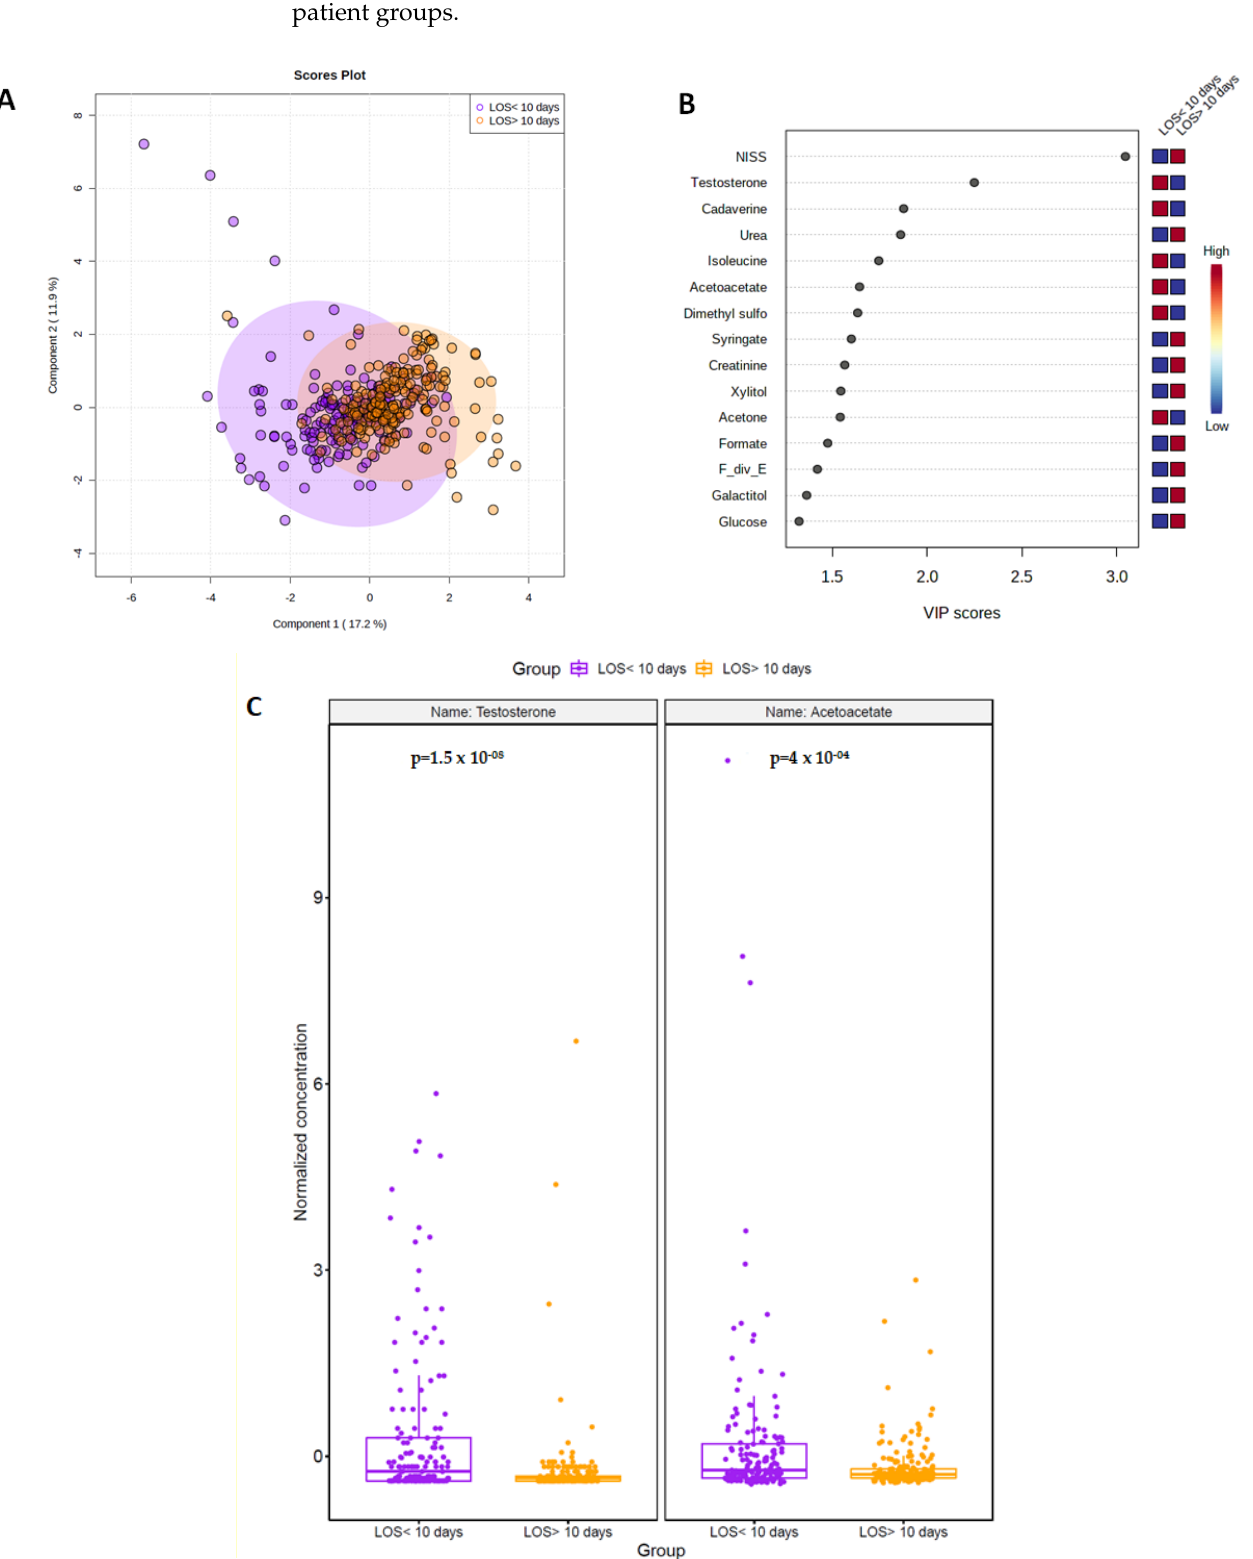
Figure 2. Trauma patients with an ICU LOS ≥ 10 days present with a distinct serum metabolome in the acute post ‐ injury phase. ( A ) A PLS ‐ DA score plot highlighting the differences in the serum metabolome in the acute post ‐ injury phase of patients with an ICU LOS < 10 (purple dots) or LOS ≥ 10 days (orange dots). ( B ) VIP score plot showing the 11 selected features with a VIP score > 1.5 that discriminated between ICU patients with a LOS < 10 or ≥ 10 days. ( C ) Comparison of testos ‐ terone and acetoacetate levels in serum samples acquired in the acute post ‐ injury phase between patients who experienced an ICU LOS < 10 or ≥ 10 days.